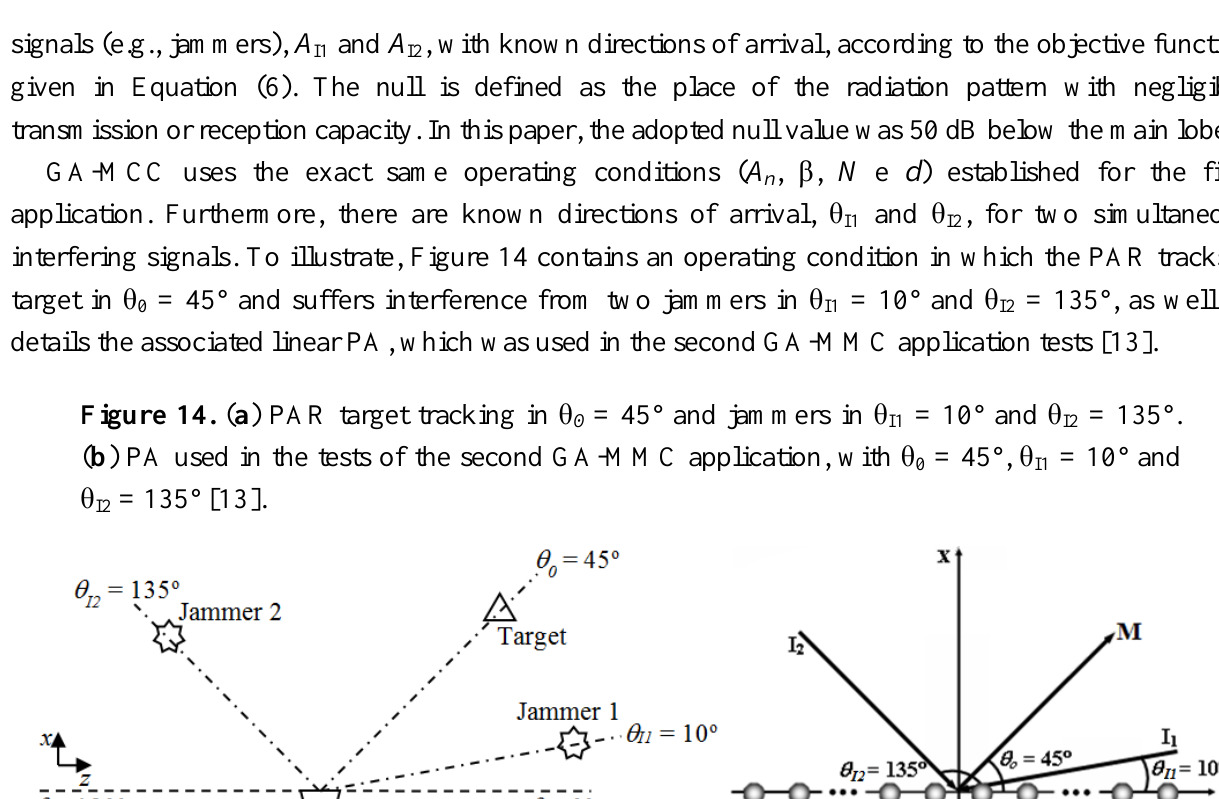
( b ) PA used in the tests of the second GA-MMC application, with θ